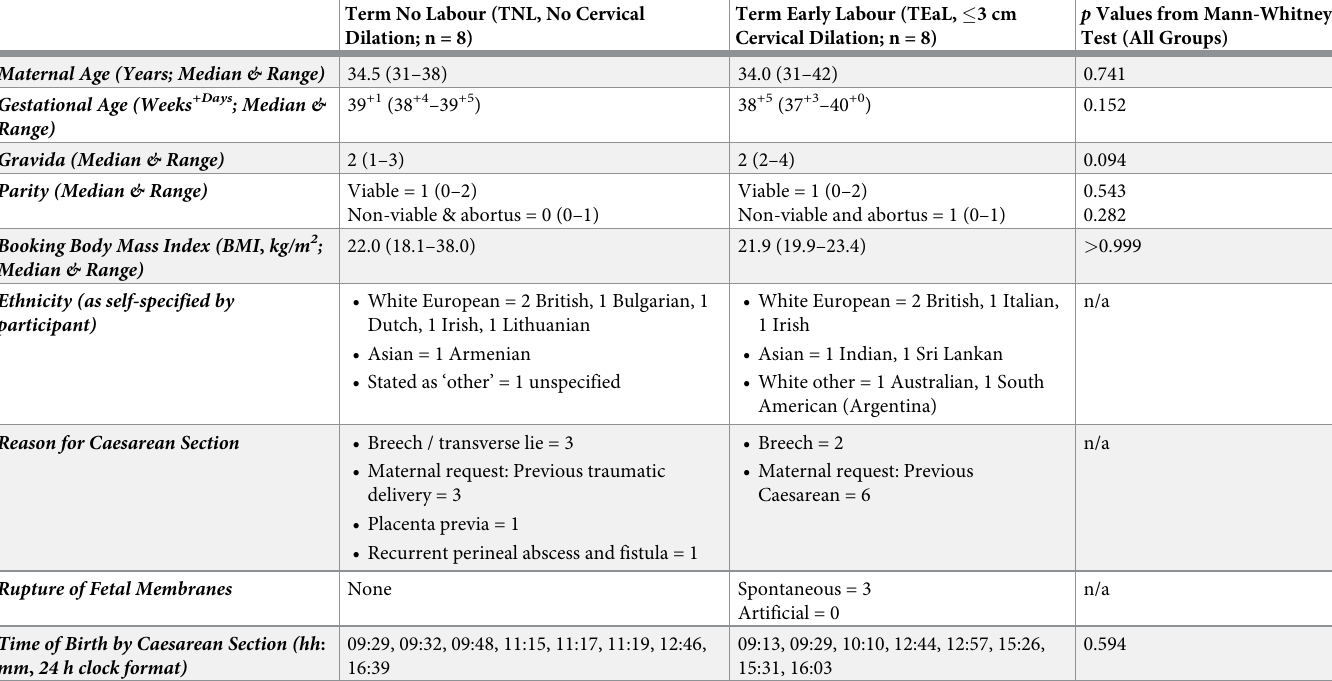
Table 4. Patient demographics for myometrium, placenta & choriodecidua biopsies used as independent ‘second cohort’ for qPCR validation of RNA-seq findings. Term No Labour (TNL, No Cervical Term Early Labour (TEaL, � 3 cm Dilation; n = 8) Cervical Dilation; n =